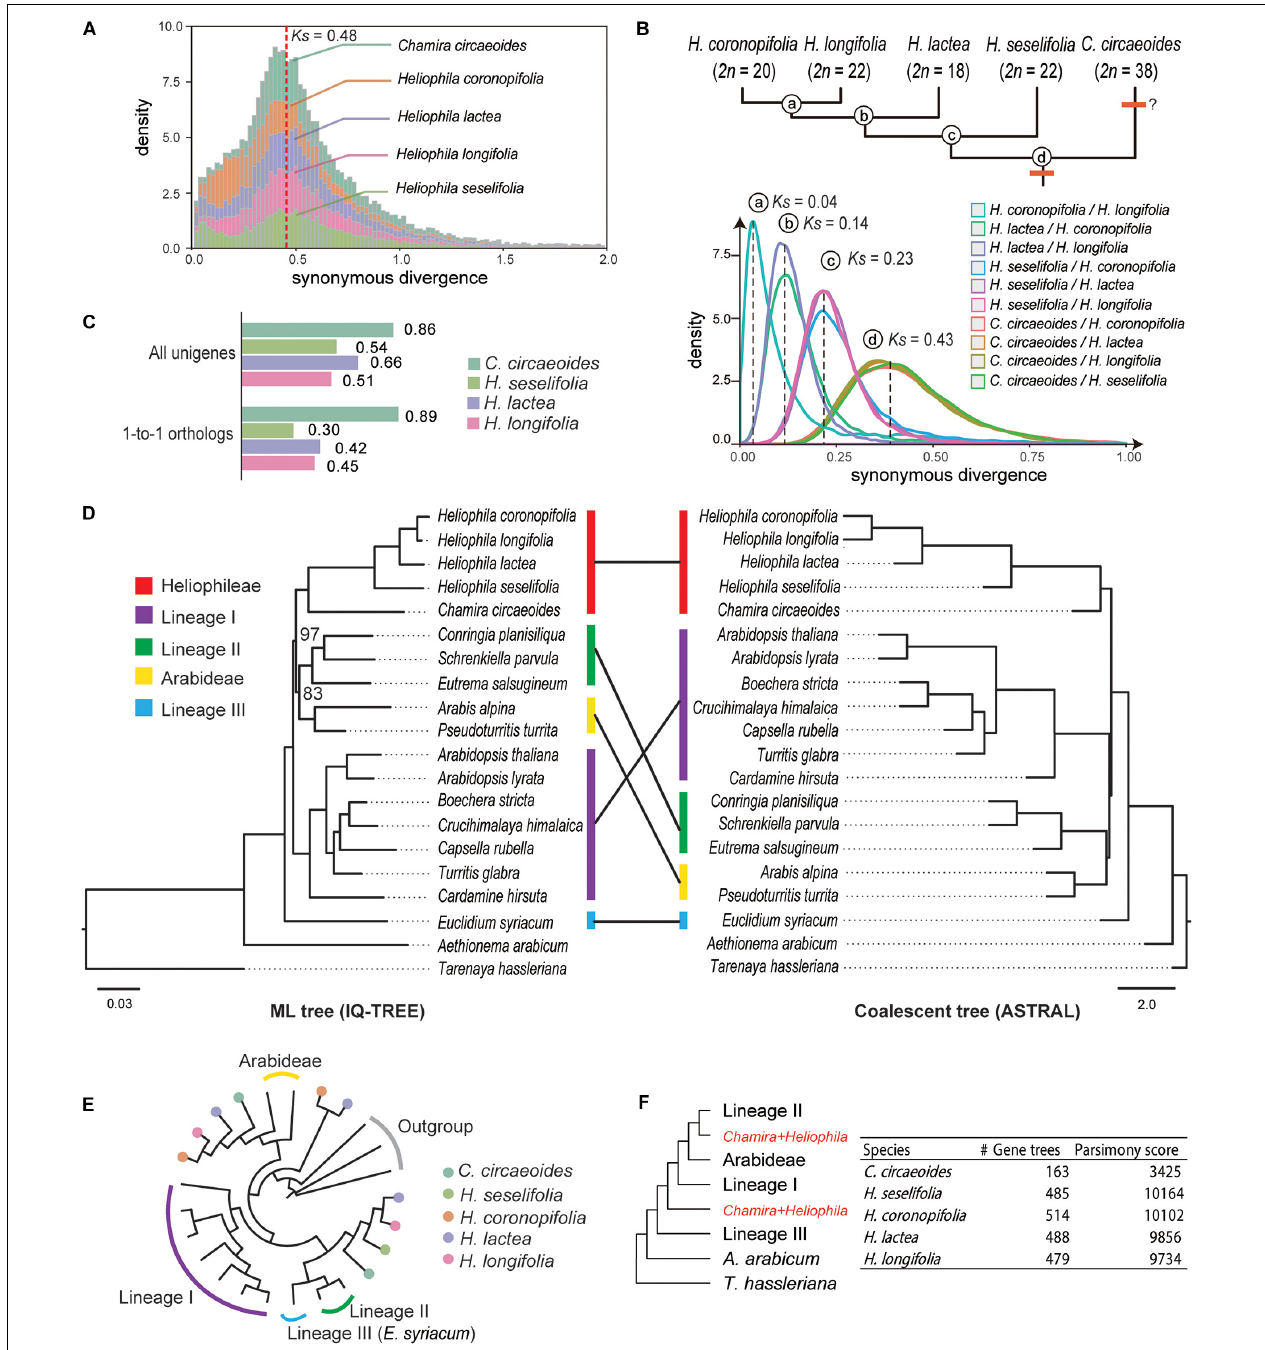
FIGURE 1 | Analyses of synonymous substitutions per synonymous site ( Ks ) and phylogenetic tree topologies. (A) Ks plots of within-species comparisons in Chamira and Heliophila species. The red dashed line indicates the position of peaks for the putatively shared WGD event. (B) Ks plots of between-species comparisons in Chamira and Heliophila species. Peaks of species divergence are indicated with dashed lines and labeled with circled letters. The upper tree topology shows the branching order of Chamira and Heliophila species as revealed by Ks analyses, with chromosome numbers labeled for each species. (C) Comparison of SNP rates in coding sequences of C. circaeoides , H. lactea , H. cf. longifolia , and H. seselifolia . (D) Phylogenetic relationship between Chamira + Heliophila and other Brassicaceae species using maximum-likelihood (ML) and coalescent approaches. Colored bars indicate different lineages. Unless otherwise mentioned, all relationships received full support in both ML and coalescent trees. Bootstrap values are labeled for two branches that failed to be fully supported in ML analysis. Scale bars below ML and coalescent trees indicate substitution per site and coalescent unit, respectively. (E) An example of gene tree topology showing phylogenetic relationship among multicopy genes of Chamira and Heliophila species. (F) The multilabeled tree with the lowest parsimony score, as inferred by gene tree reconciliation analyses in all species. The ASTRAL topology was used as the input of species tree hypothesis.